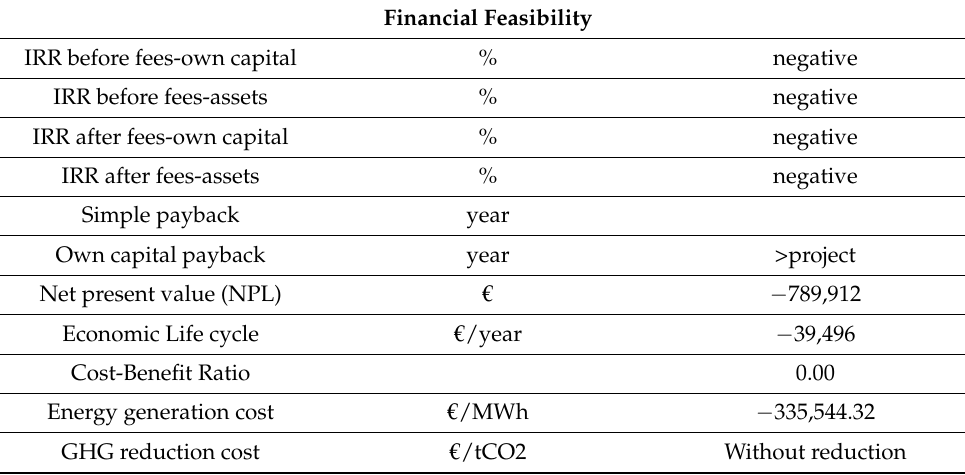
Table 19. Financial feasibility of the